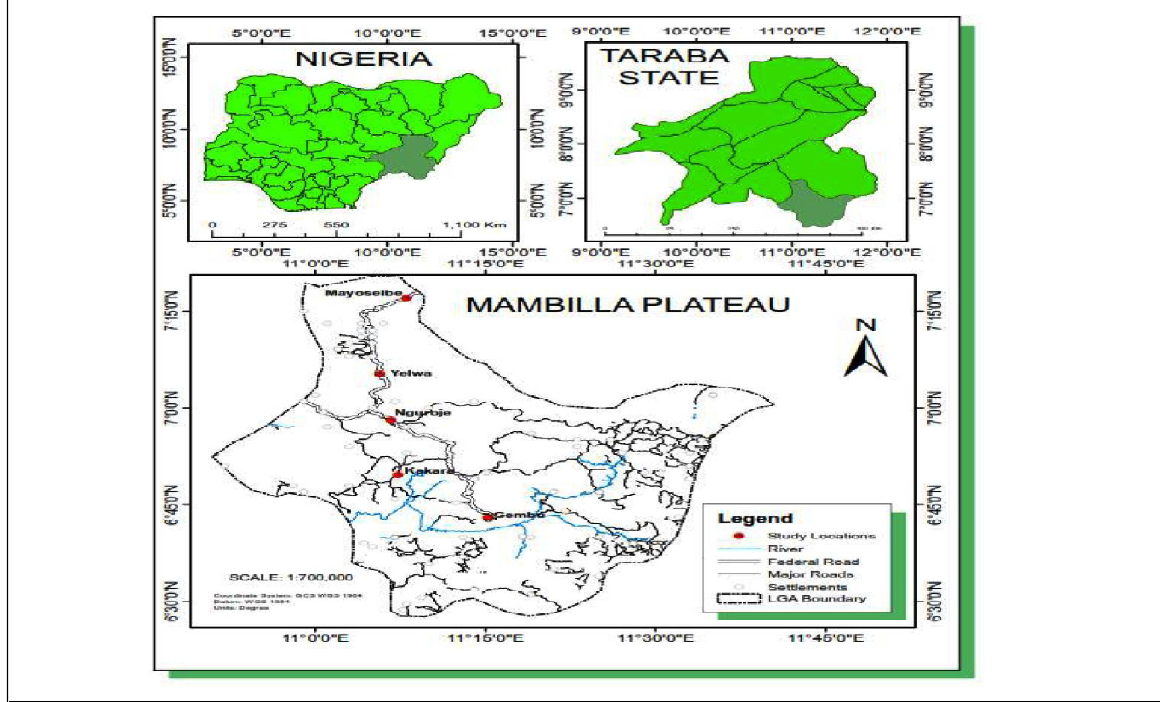
Figure 1: Map of Nigeria showing the study